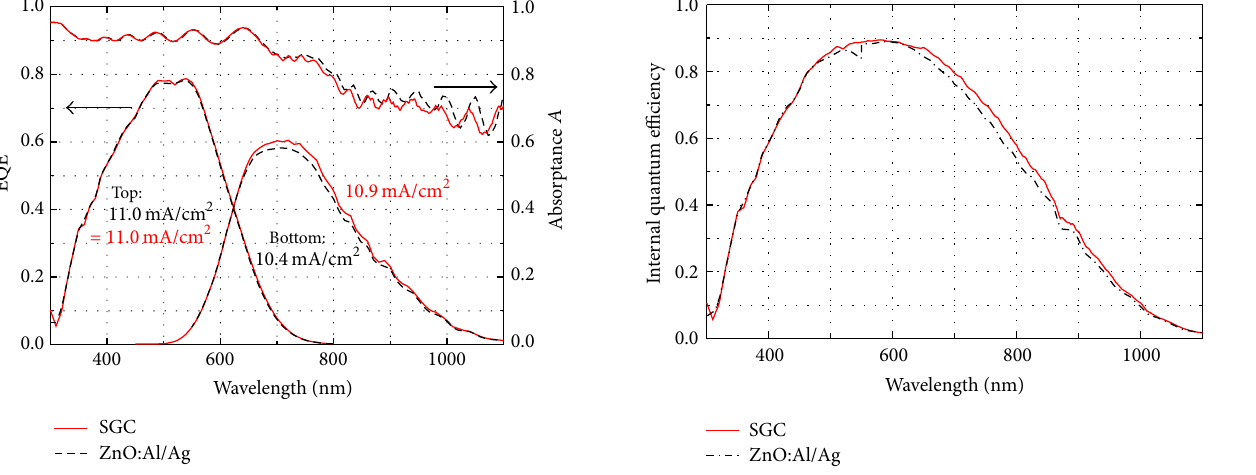
Figure 2: External quantum efficiency (EQE) (left 𝑦 -axis) and absorptance ( 𝐴 ) (right 𝑦 -axis) of the a-Si:H top solar cell and 𝜇 c- Si:H bottom solar cell with ZnO:Al/Ag reflector (black dash line) and SGC reflector (red solid line).